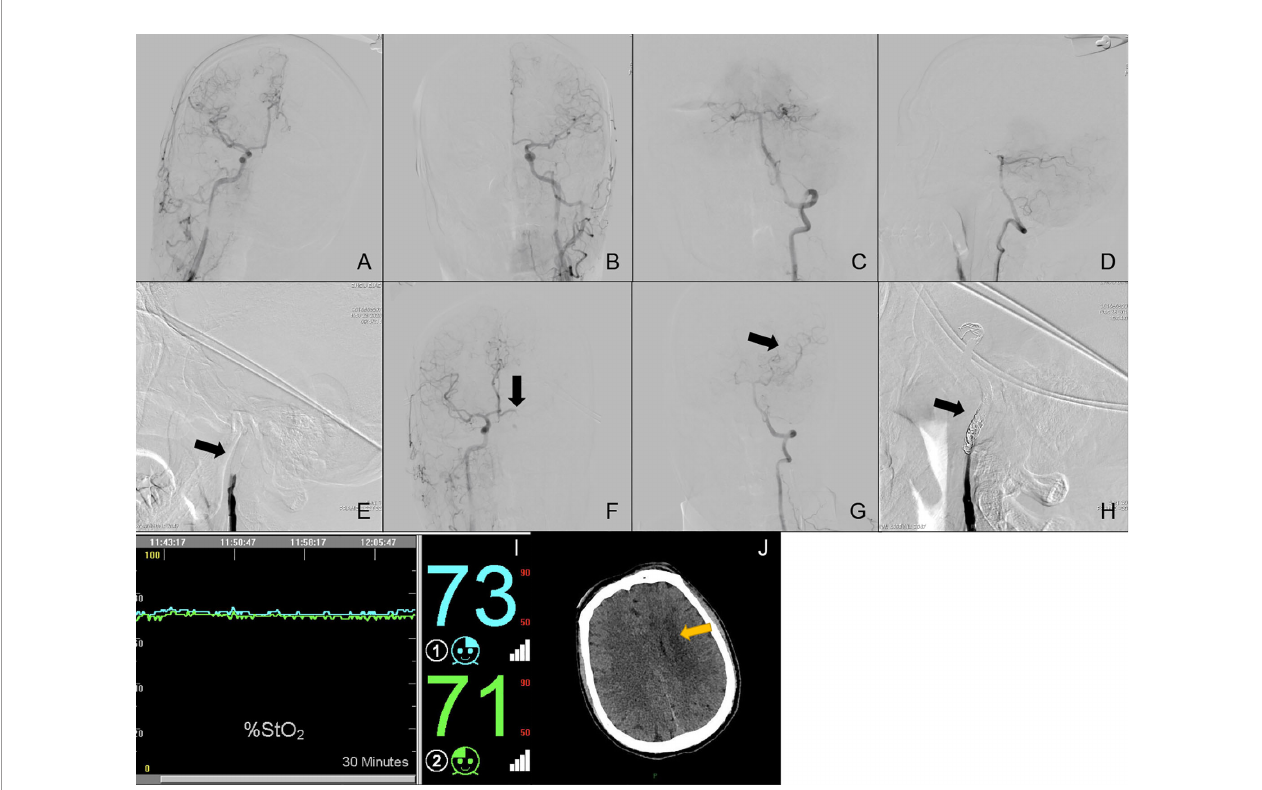
FIGURE 4 | Cerebral angiography and cerebral rSO 2 monitoring of Case No. 50. (A – H) Multi-side view of cerebral angiography. (I) Real-time rSO 2 monitoring. The blue line represented rSO 2 on the left cerebral hemisphere, the green line represented rSO 2 on the right cerebral hemisphere. (J) CT scan of Case No. 50 after BTO and ICA occlusion, the yellow arrow indicates delayed cerebral infraction after therapeutic ICA